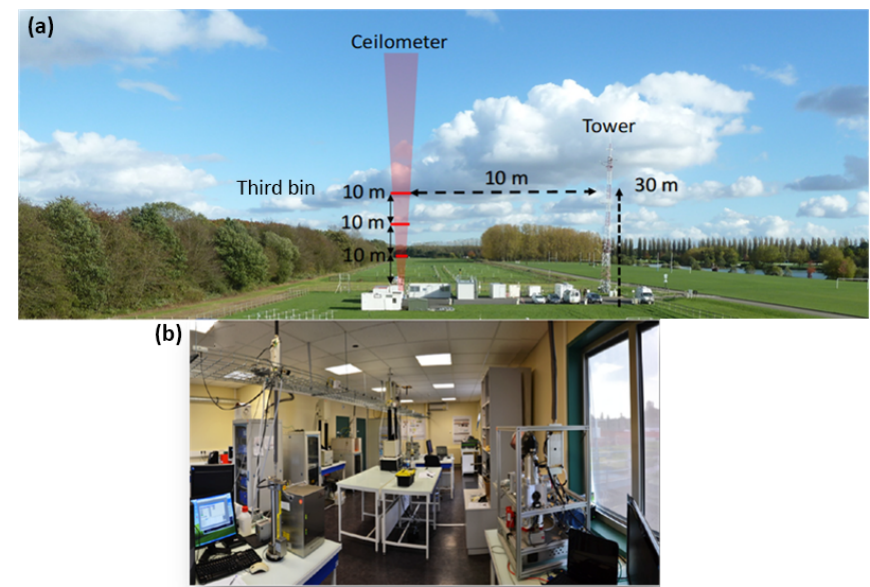
Figure 1. (a) Experimental setup (not 1 : 1 scale) for studying hygroscopic growth using the automatic instrumentation (ceilometer and hygrometer) and (b) in situ monitoring station at the ACTRIS SIRTA